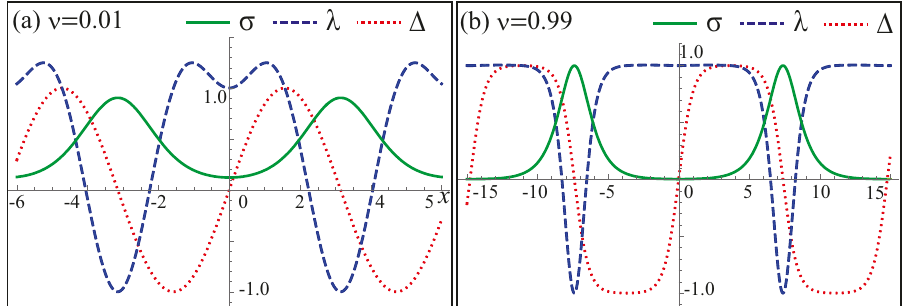
Figure 1 . The con(cid:12)guration of (cid:27) (solid line) and (cid:21) (dashed line) for (cid:1) = (cid:0) m tanh mx (dotted line). Here we normalize as (cid:27) (0) = 1 and m = 1.